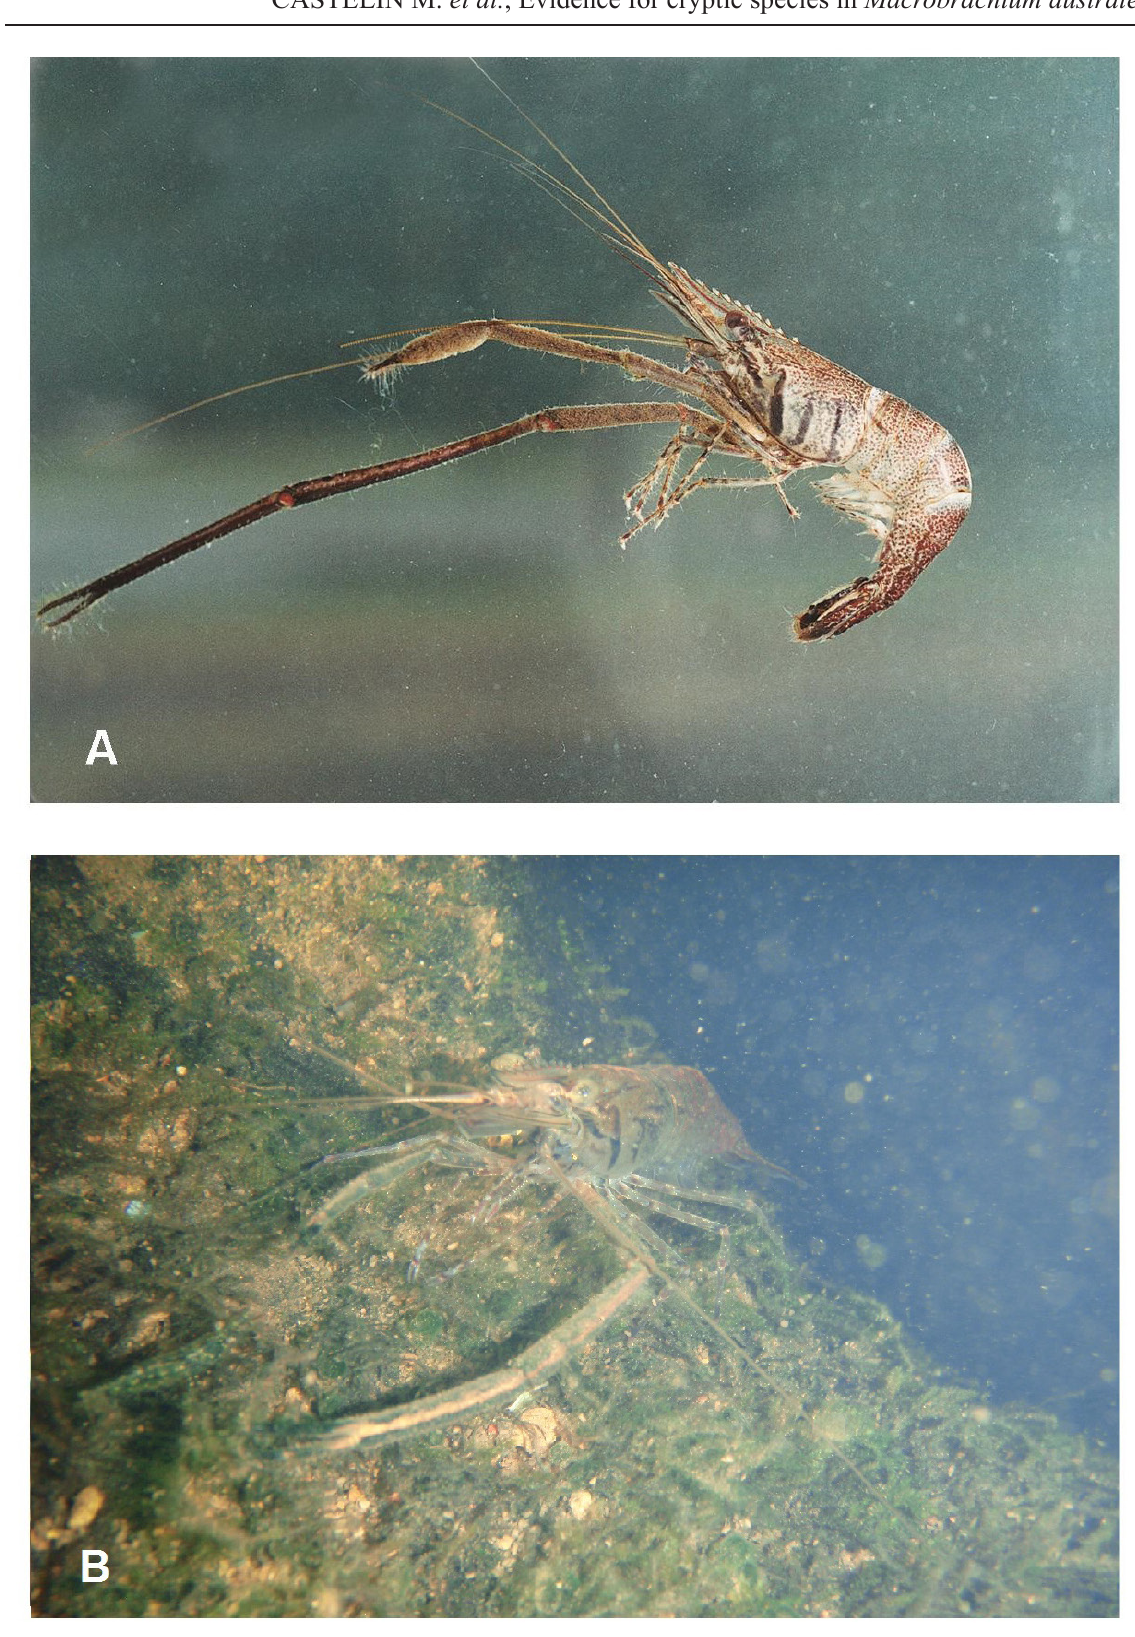
Fig. 4. A . Live coloration of Macrobrachium australe (Guérin-Méneville, 1838 in Guérin-Méneville 1829–1838) (photo: E. Vigneux). B . Live coloration of M. ustulatum (Nobili, 1899) (photo: P.